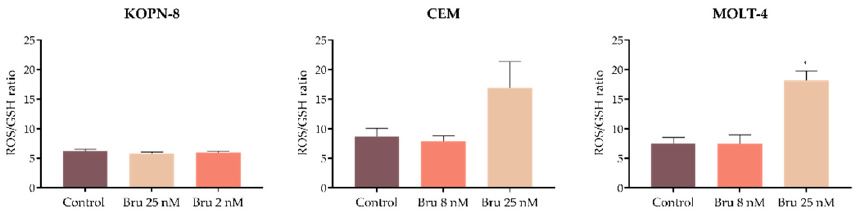
Figure 6. Oxidative stress evaluation by ROS/GSH ratio. Results are expressed as mean fluorescence intensity (MFI) and represent mean ± SEM obtained from at least 3 independent experiments. Bru, Brusatol; ROS; reactive oxygen species; GSH, reduced glutathione. * p < 0.05 compared with untreated cell (control).